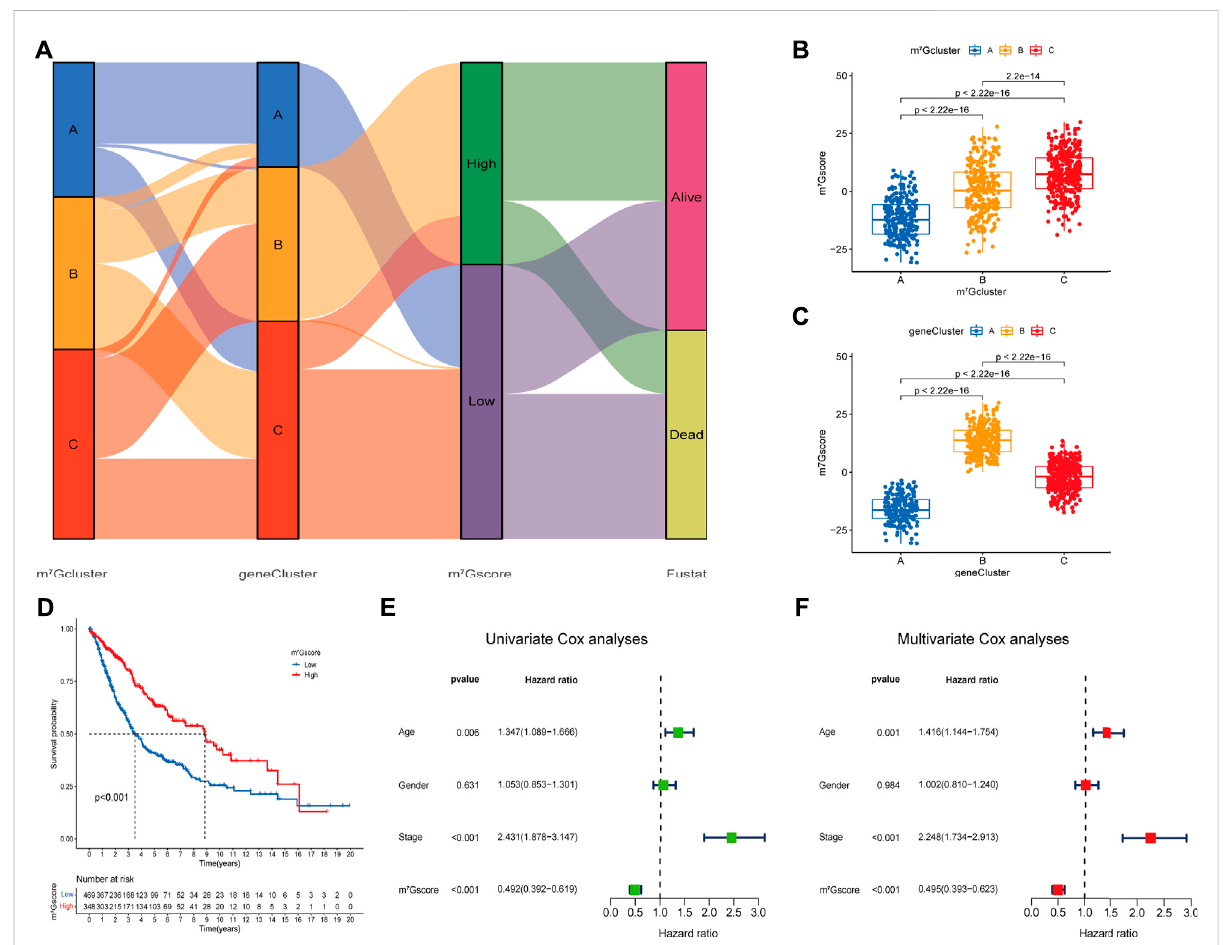
FIGURE 5 Construction of the m 7 G signature and correlation of m 7 Gscore with clinicopathological features. (A) Alluvial diagram shows the changes of m 7 G clusters, gene clusters, m 7 Gscore and survival state. (B) Differences in m 7 Gscore among three m 7 G clusters ( p < 0.001, Kruskal-Wallis test). (C) Differences in m6Ascore among three gene clusters ( p < 0.001, Kruskal-Wallis test). (D) Survival analyses for low (469 cases) and high (348 cases) m 7 Gscore groups in the four cohorts using Kaplan-Meier curves ( p < 0.0001, Log-rank test). (E,F) Univariate (E) and multivariate (F) analyses for m 7 Gscore using the Cox regression